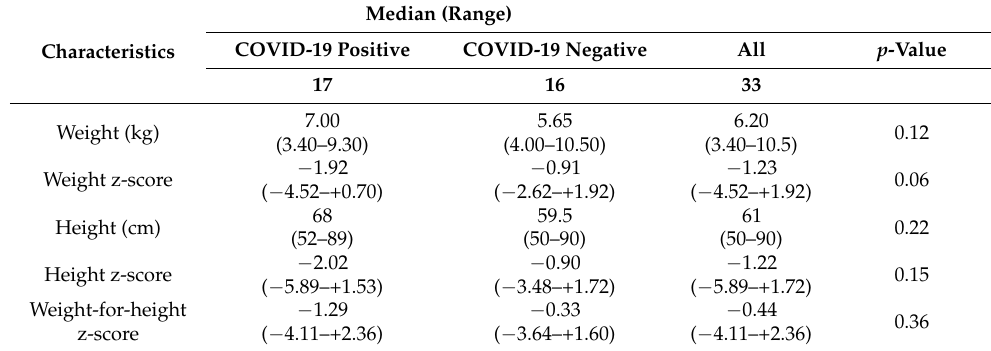
Table 2. Anthropometric measurements of the study group according to SARS-CoV-2 infection